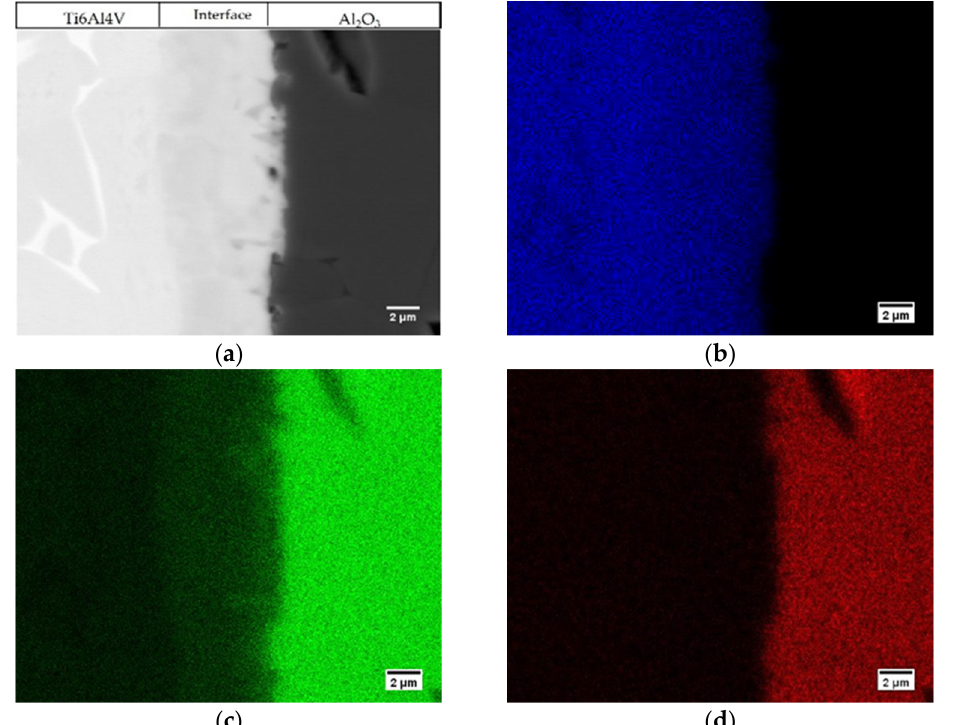
Figure 5. ( a ) SEM image and EDS elemental maps of ( b ) Ti, ( c ) Al, and ( d ) O of the interface obtained without interlayer at 1000 °C and dwell time of 10 min.